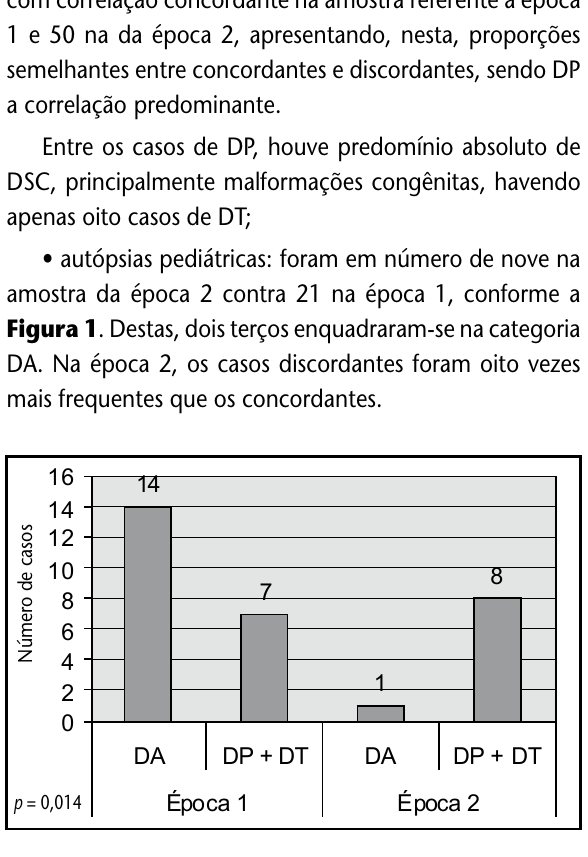
Figura 1 – Frequências de casos concordantes (DA) e discordantes (DP+DT) em 30 autópsias pediátricas do HC-UFMG, realizadas em duas épocas distintas (1975 a 1978 e 1997 a 2000), com evidente diminuição numérica e aumento de casos com correlação discordante na época 2: DA época 1 = 14; DP + DT época 1 = 7; DA época